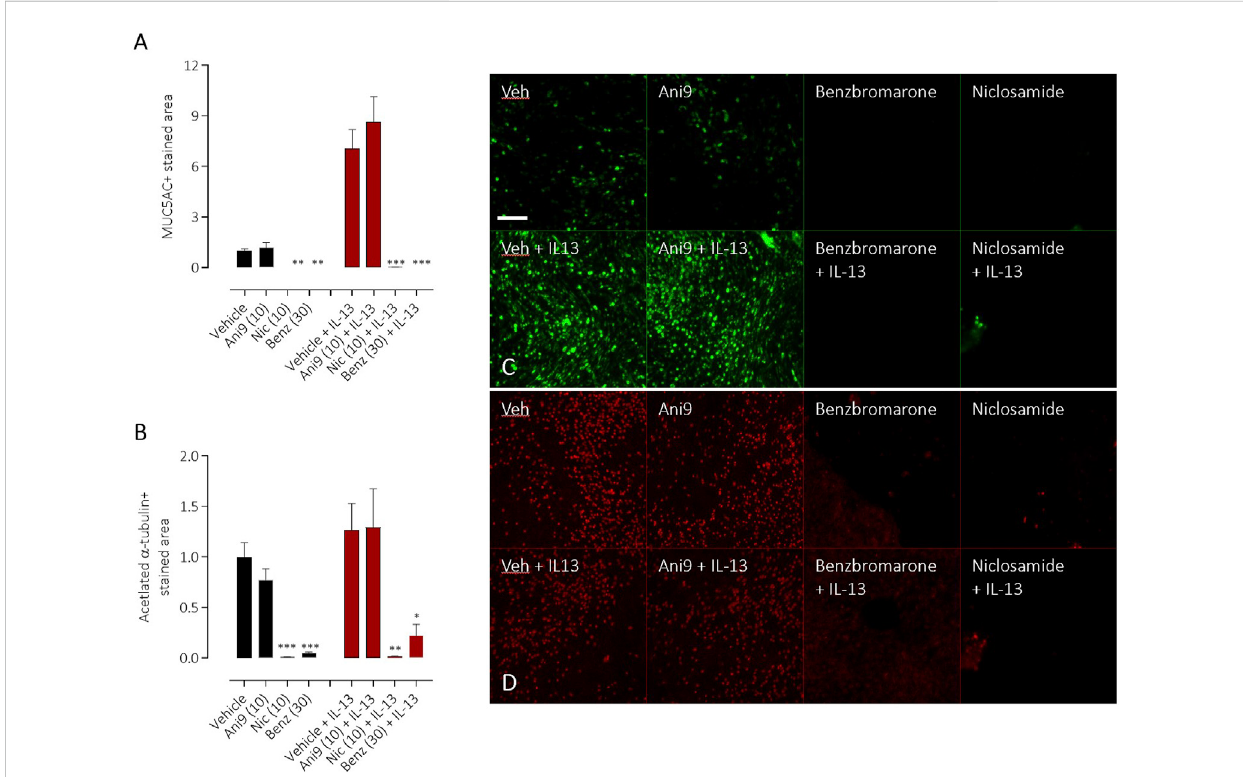
FIGURE 7 Effects ofTMEM16A blockerson IL-13 stimulated gobletcell formation inHBE. The effectsof Ani9,niclosamide (Nic) and benzbromarone(Benz)on normal (black bars) or IL-13 treated (red bars) HBE cultures. Mean ± SEM stained areas of MUC5AC + goblet cells (A) and acetylated α -tubulin + multiciliated cells (B) are shown ( n = 5 inserts per group). Concentrations of test compounds are shown in brackets as µM. *, ** and *** denote p < 0.02, p < 0.006 and p < 0.0002 respectively following a one-way ANOVA using post hoc Dunnett ’ s test. Sample immuno fl uorescence images are shown illustrating the respective staining for MUC5AC+ goblet cells (C) and acetylated α -tubulin+ multiciliated cells (D)